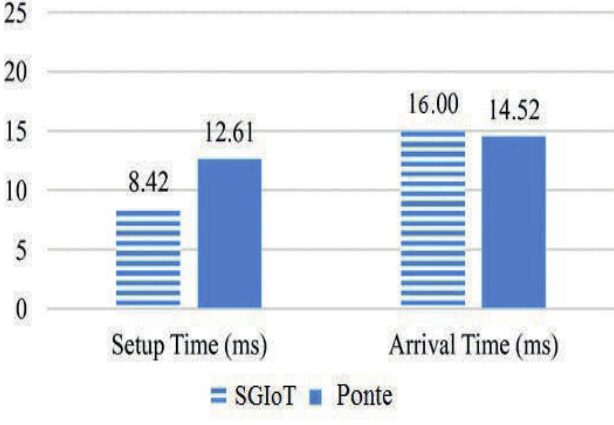
Fig. 6. CoAP – MQTT communication case.